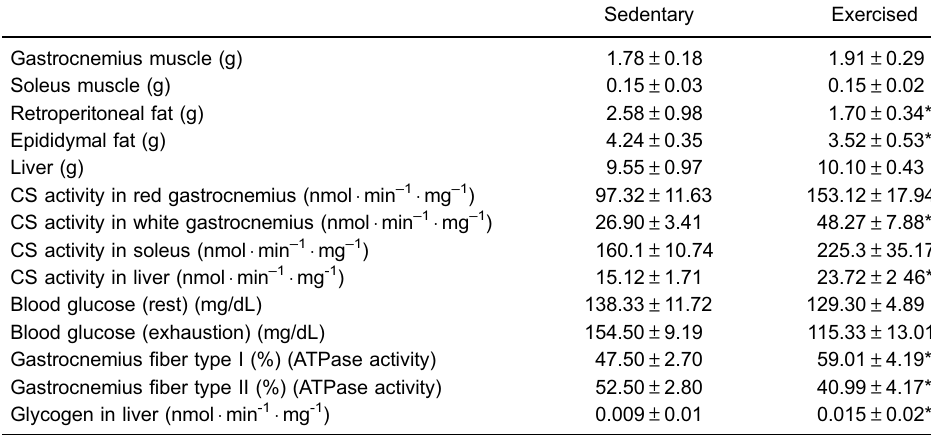
Table 1 . Effects of endurance training on evaluated